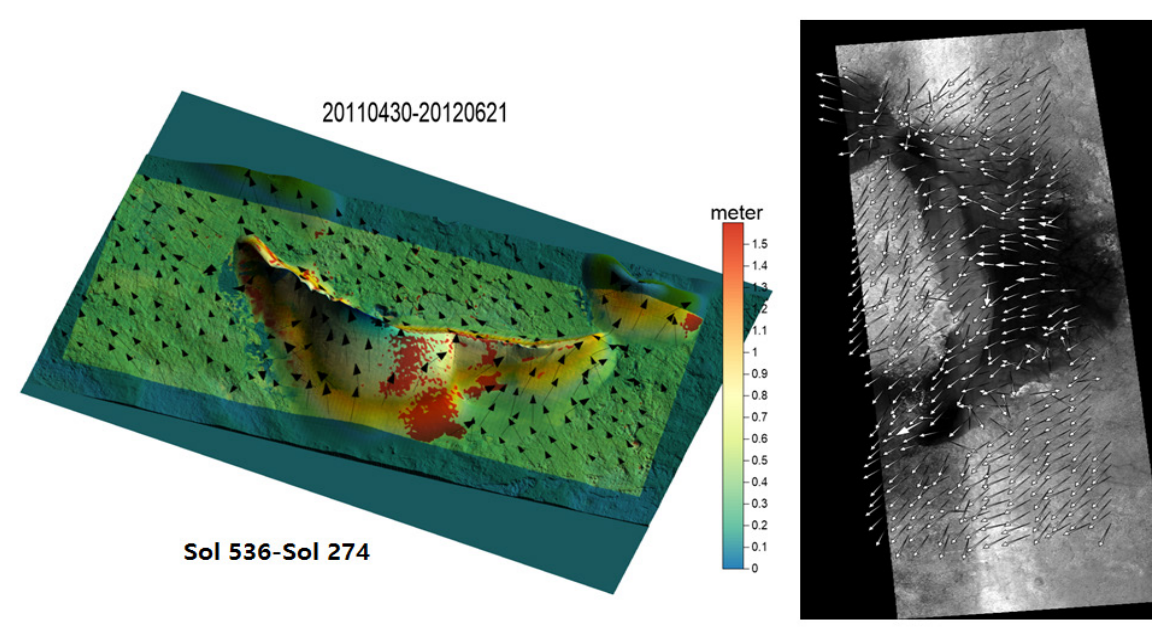
(b) An example of detailed migration measurements for 1 year period. Figure 6 . Traced dune migrations over Kaiser.